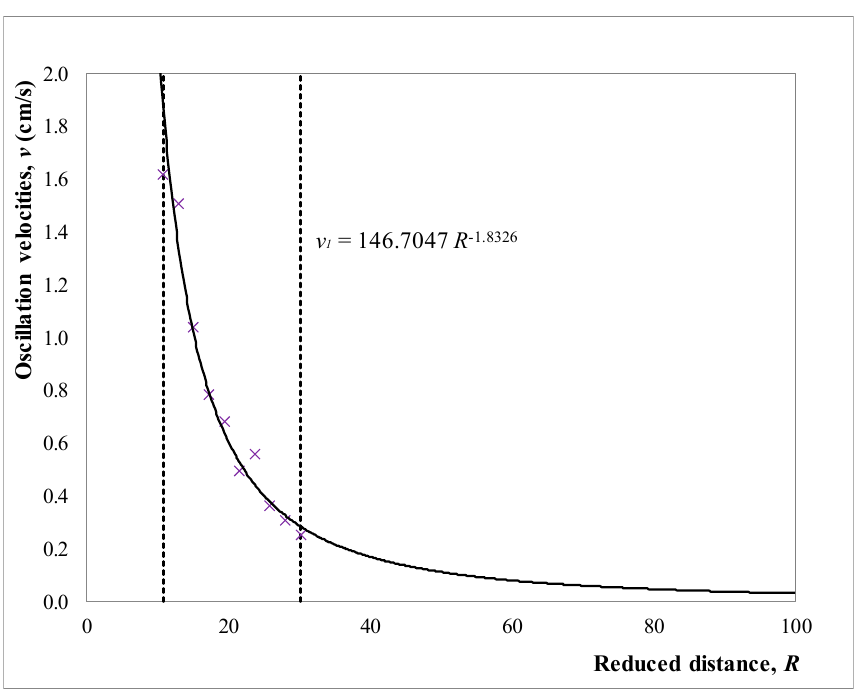
Figure 2. Graphic representation of rock masses oscillation velocity in Majdanpek open pit. Model 2 v 2 = 158.5234 R − 1.8568 (45) Model